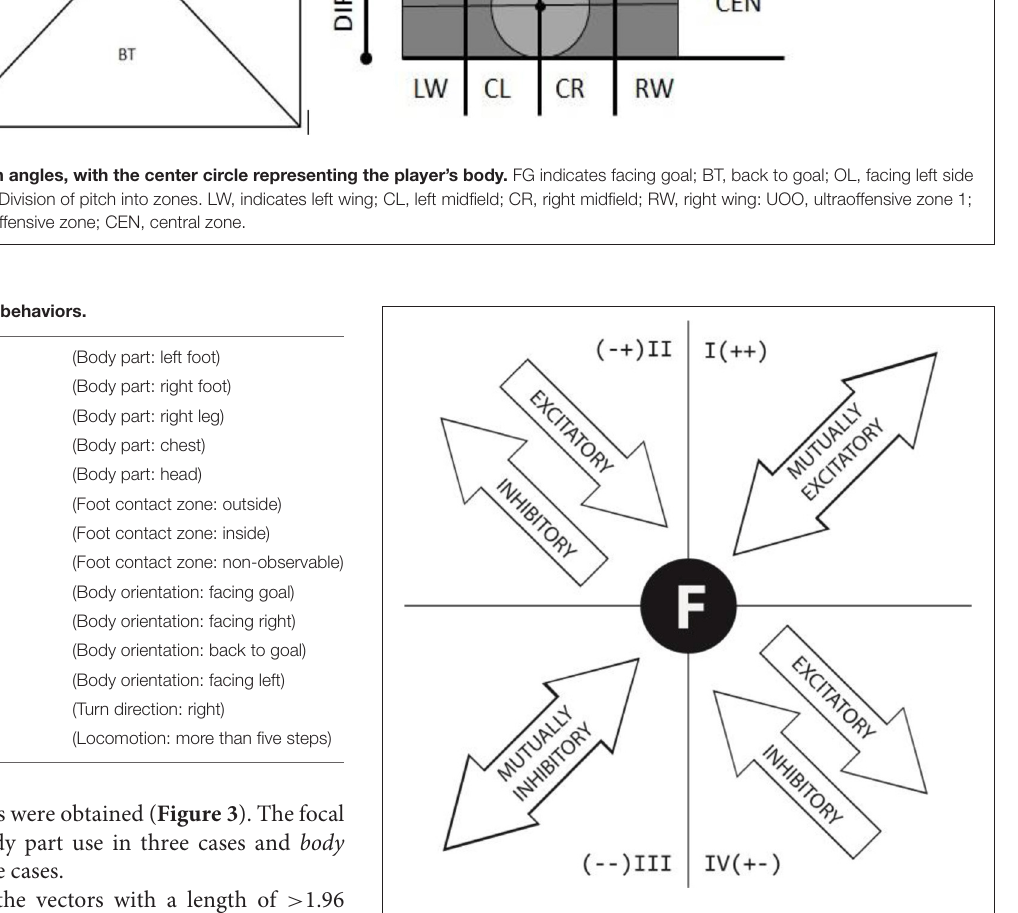
FIGURE 2 | Graphic depiction of relationships between conditional and given behaviors in polar coordinate maps according to quadrant in which vector is